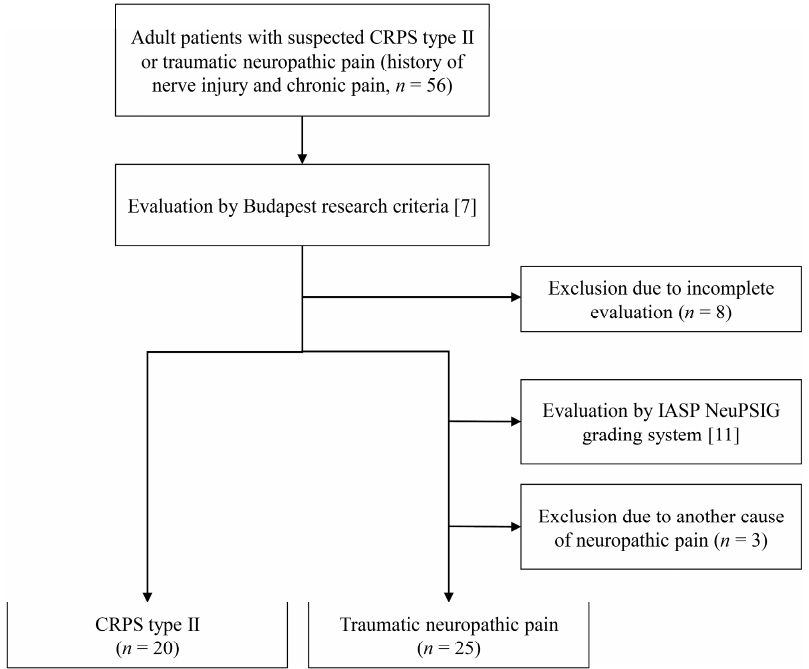
Figure 1. Flowchart of the study population selection. CRPS: complex regional pain syndrome; IASP: International Association for the Study of Pain; NeuPSIG: Special Interest Group on Neuropathic Pain. Table 1. Clinical Characteristics of participants with CRPS type II and traumatic neuropathic pain.